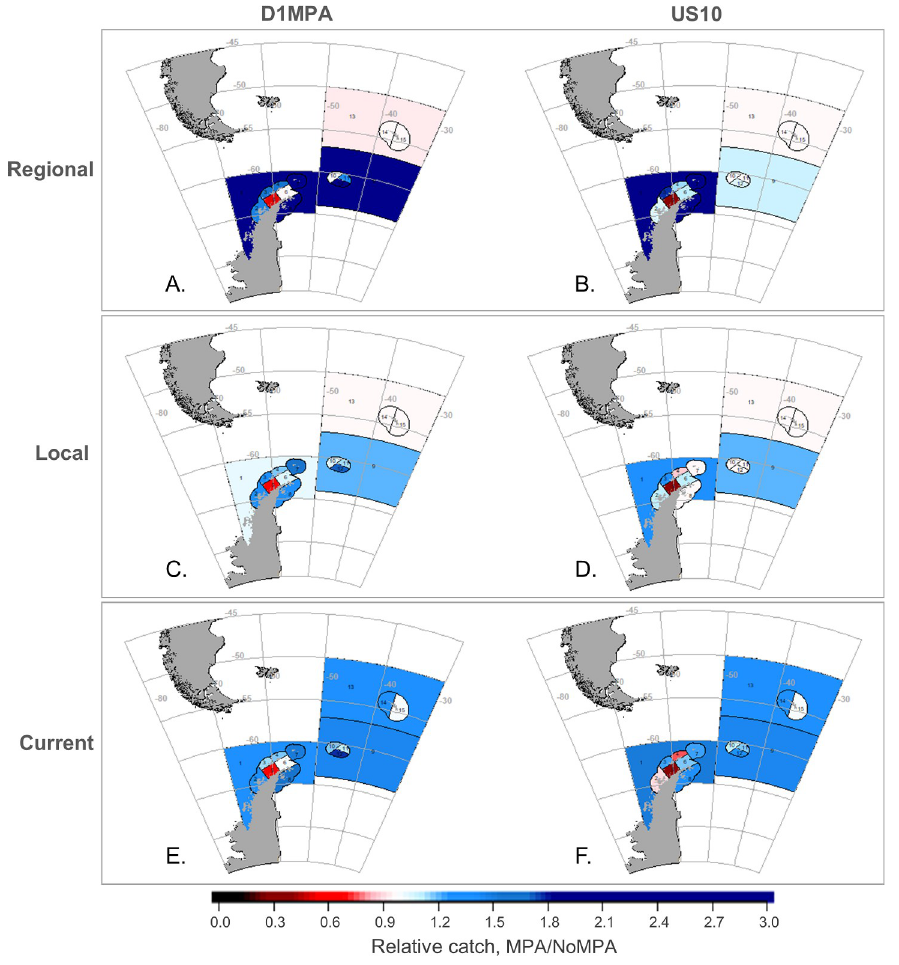
Fig 6. Outcomes for the fishery by SSMU in both MPA scenarios. Change in catch with the MPA relative to the No MPA scenario (i.e. MPA/No MPA); all details as in Fig 4.